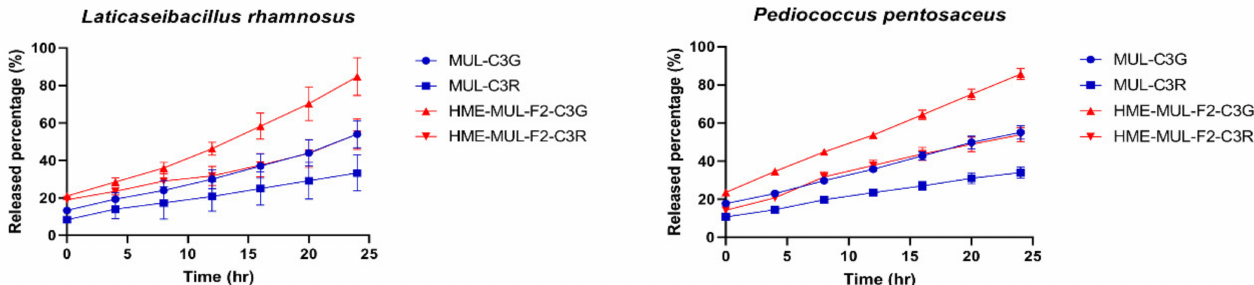
Figure 9. Released anthocyanins content and release profile of L. rhamnosus and P. pentosaceus cultured with mulberry raw materials (MUL) and HME-DDS formulate (HME-MUL-F2).The trend of the ACN content in P. pentosaceus after treatment with HME-MUL-F2 formulation was similarly observed. In the case of MUL, C3G and C3R contents were 5.0 ug/mL and 3.3 ug/mL, respectively, at the beginning of the culture. At 4 h after incubation, they were decreased to 0.17 ug/mL and 0.13 ug/mL, respectively. At 24 h after incubation, they were decreased to a level of 0.02 ug/mL. In the case of